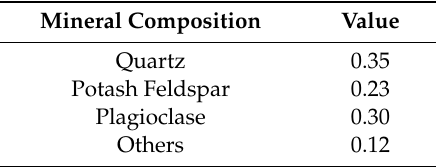
Table 2. Mineral composition of rock